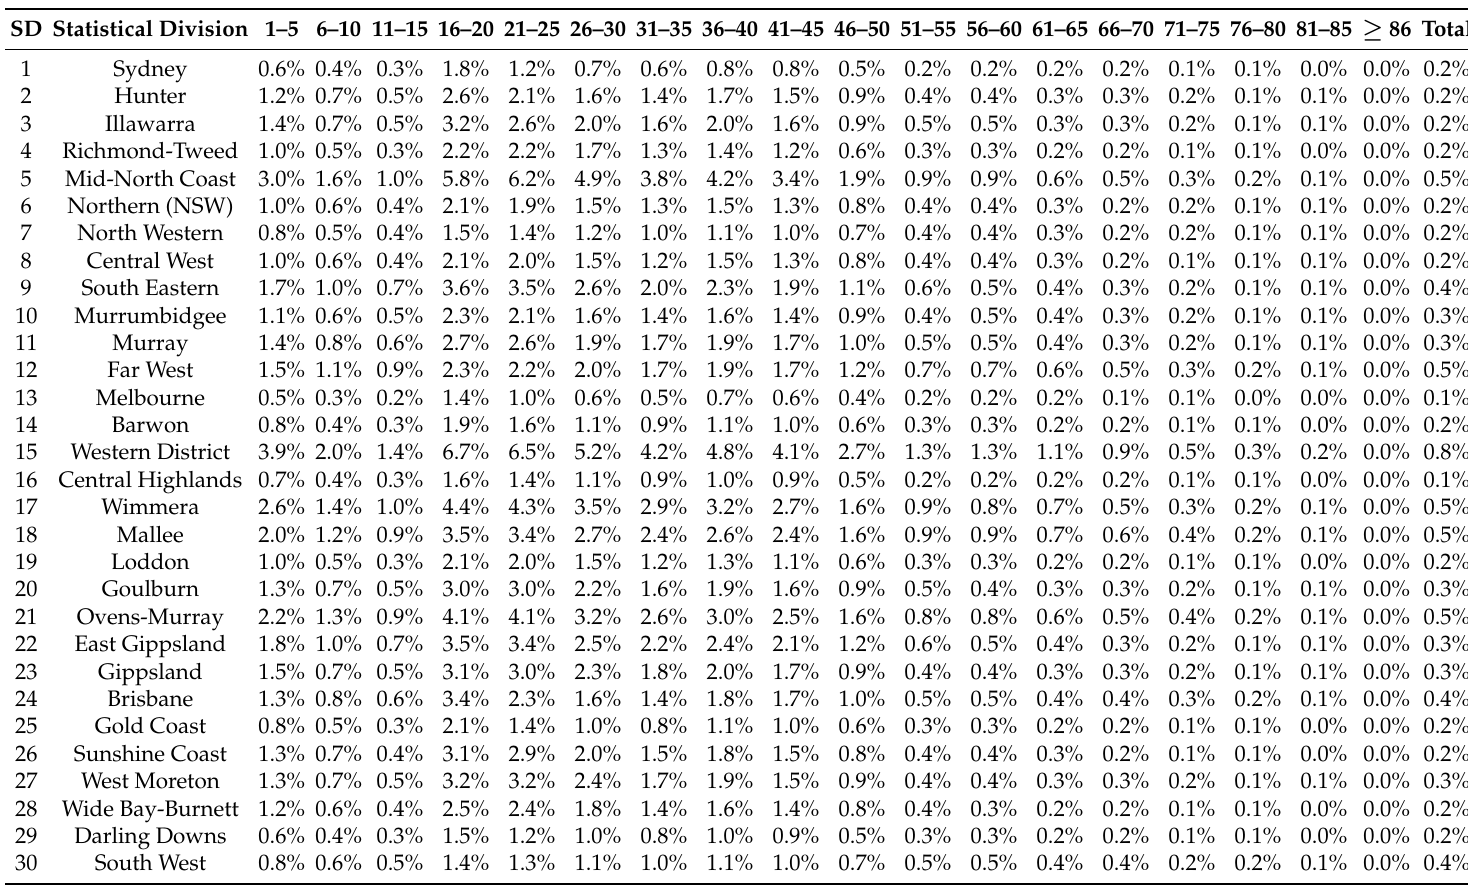
Table A3. Proximity Effects per 10